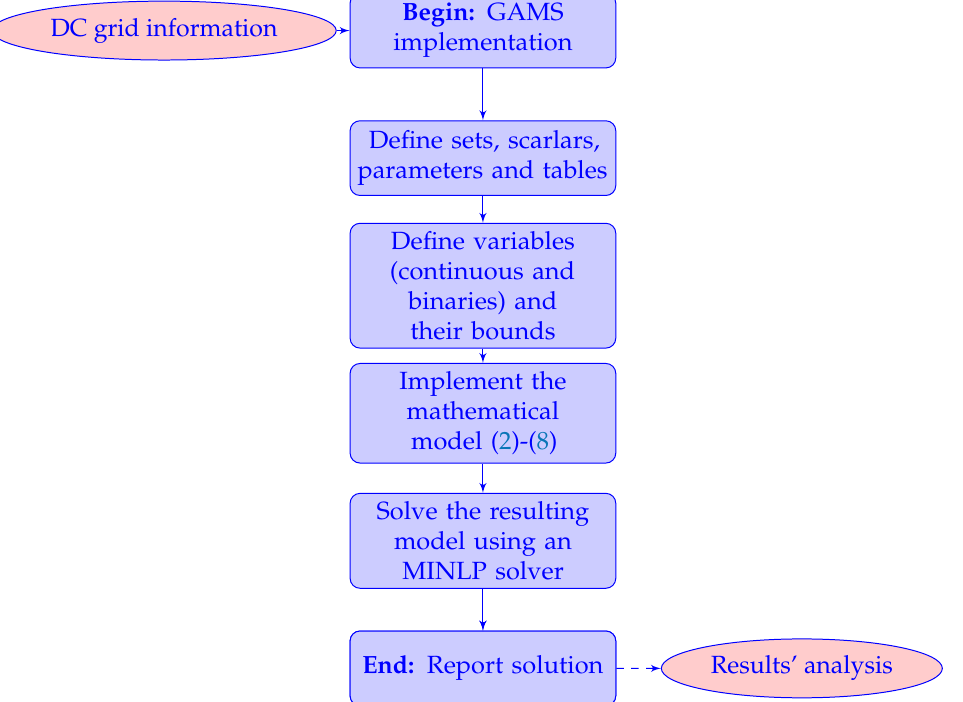
Figure 1. Flow chart of the proposed optimisation approach for optimal reconfiguration of DC grids.